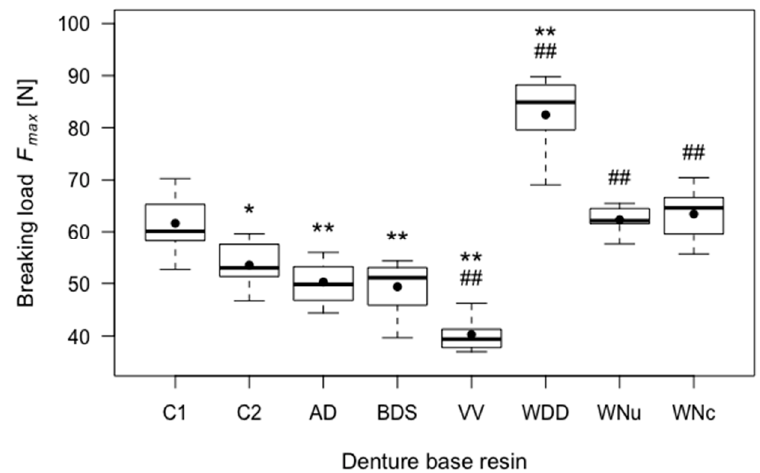
Figure 2. Boxplots of the breaking loads ( F max ) of the tested resins. Significant differences ( p < 0.05) with respect to control group C1 are indicated by *, highly significant differences ( p < 0.01) with respect to control group C1 are indicated by **, and ## indicates highly significant differences ( p < 0.01) with respect to control group C2. Table 2. Detailed mechanical properties and fracture surface roughness.